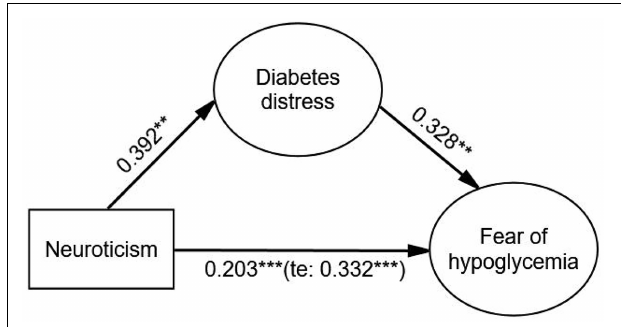
FIGURE 1 | The mediating effect of diabetes distress on the relationship between neuroticism and FoH. Standardized estimating of 5,000 bootstrap sample. Age, sex, duration of diabetes, duration of insulin use, hypoglycemic episodes in the past year, and living alone were controlled. te, total effect. Significant codes: *** p < 0.001, ** p < 0.01.